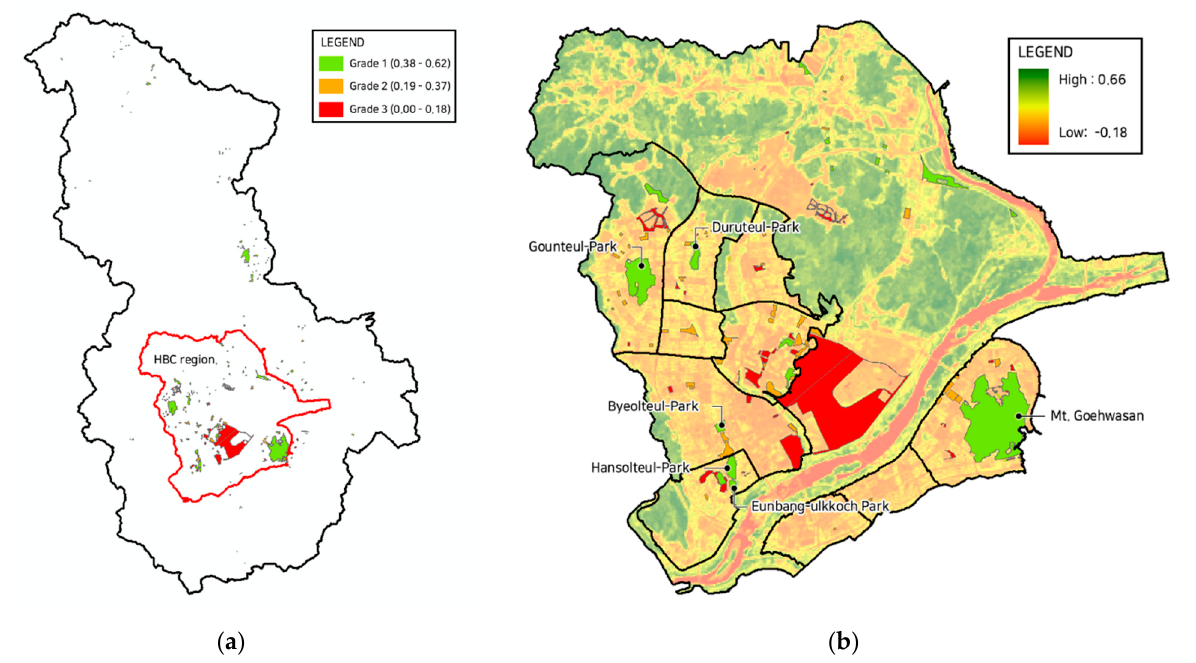
Figure 5. Distribution of wind-spreading forest (WSF): ( a ) Sejong; ( b ) HBC region (expressed with vegetation index). Table 2. Grades and vegetation index of major wind-spreading forests. Grade Target Areas